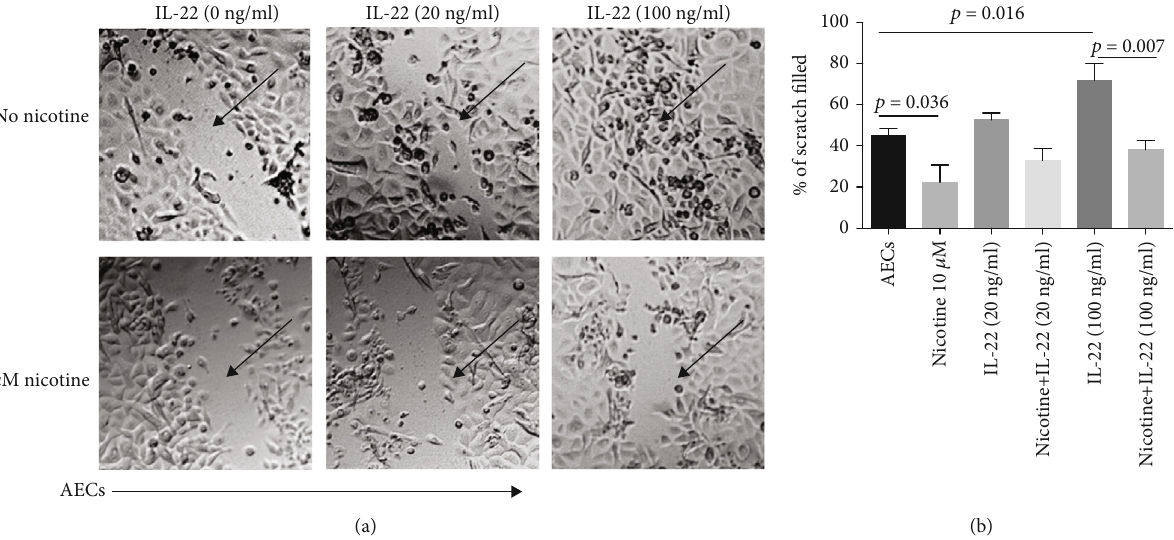
Figure 2: Nicotine inhibits IL-22-mediated epithelial cell repair. Primary AECs were grown to 95% con fl uence on 12-well culture dishes that were then scratched and treated with IL-22+ (with)/- (without) nicotine 10 μ M (Nic) at the concentrations shown. (a) Photomicrographs shown are 72h later. (b) Quantitation of the data. Data is presented as the mean ± SD of 5 experiments using AECs from 2 di ff erent donors. Arrows point to the scratches. Scale for micrograph is 20 μ